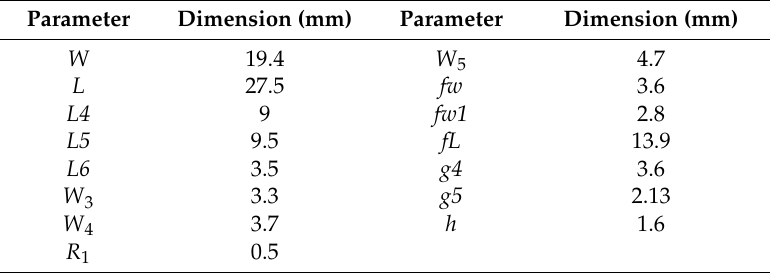
Table 3. Antenna design parameters according to Figure 4.